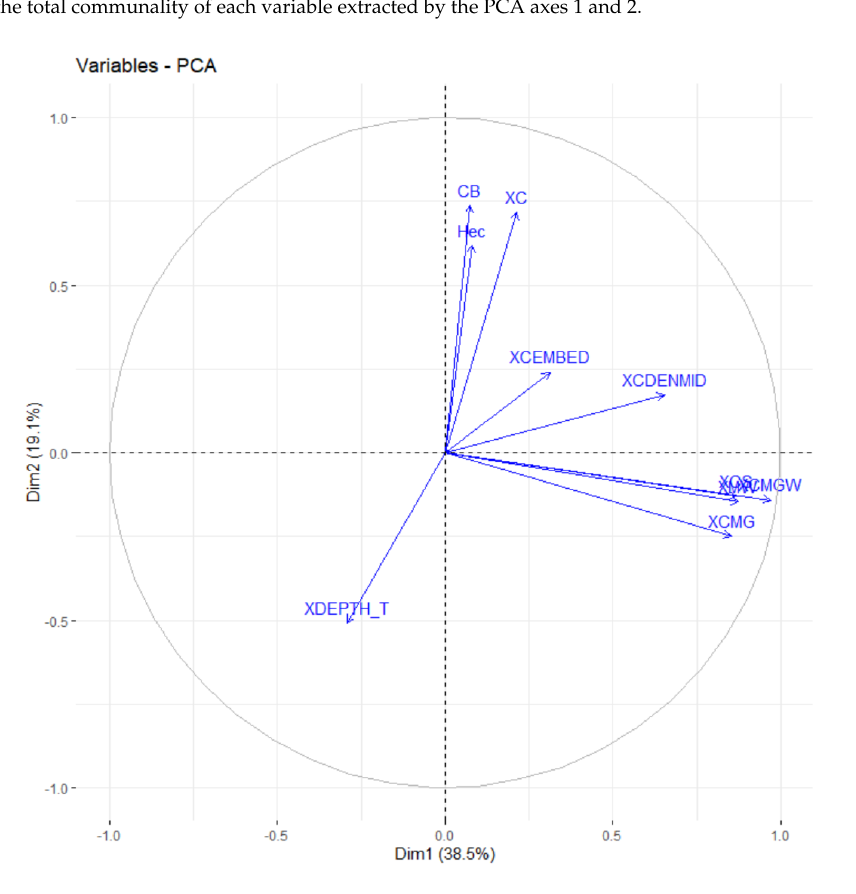
The values under columns Axis.1 and Axis.2 are the factor loadings and inform us of the contribution of each variable to the formation of the multidimensional space shown by the two PCA. Comm. (%) is the percentage of the total communality of each variable extracted by the PCA axes 1 and 2.